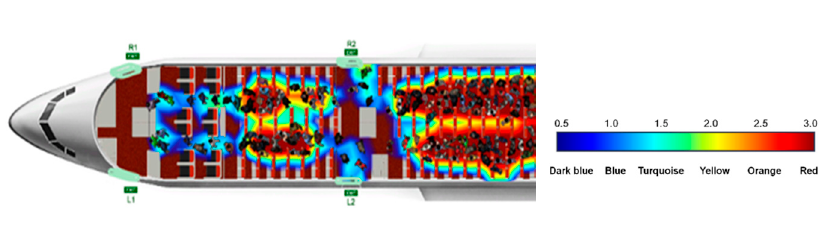
Figure 3. The density level of passenger displayed. The colors represent density level of passenger (Occs/m 2 ).